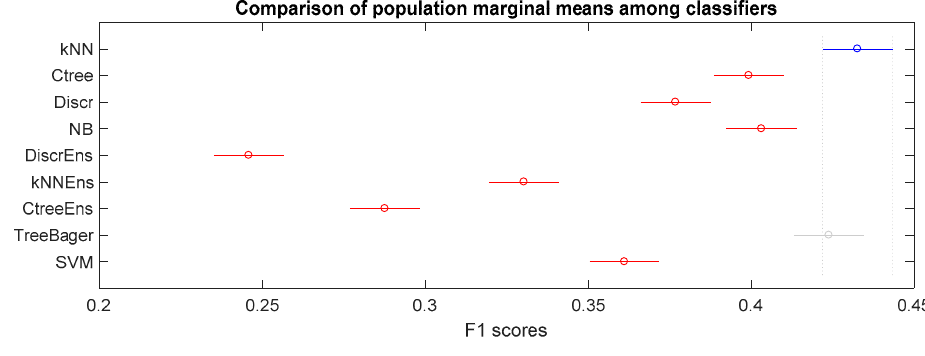
Figure 10. F1 scores by classification technique.